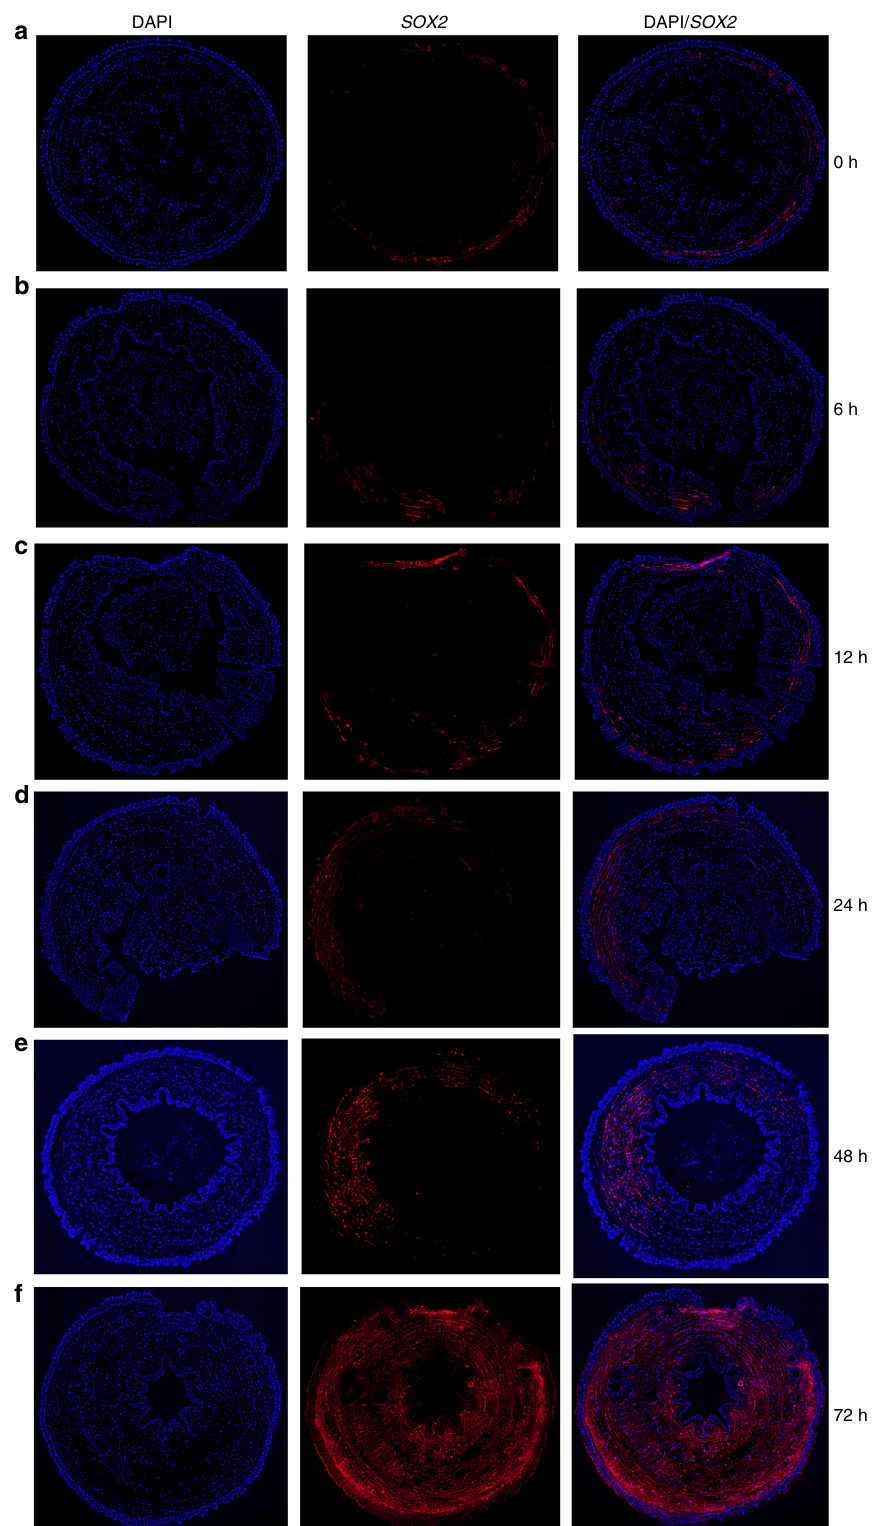
Fig. 7 In situ hybridization of gene SOX2 in cross sections at 6 different time points post-amputation in the earthworm. The slice size was 10 μ m. The 6 time points post-amputation included 0 ( a ), 6 ( b ), 12 ( c ), 24 ( d ), 48 ( e ) and 72 ( f ) hours. The red fl uorescence represented positive signals and DAPI (blue fl uorescence) was used to stain cell nucleus. Similar results in a – f could be ensured by three independently biological